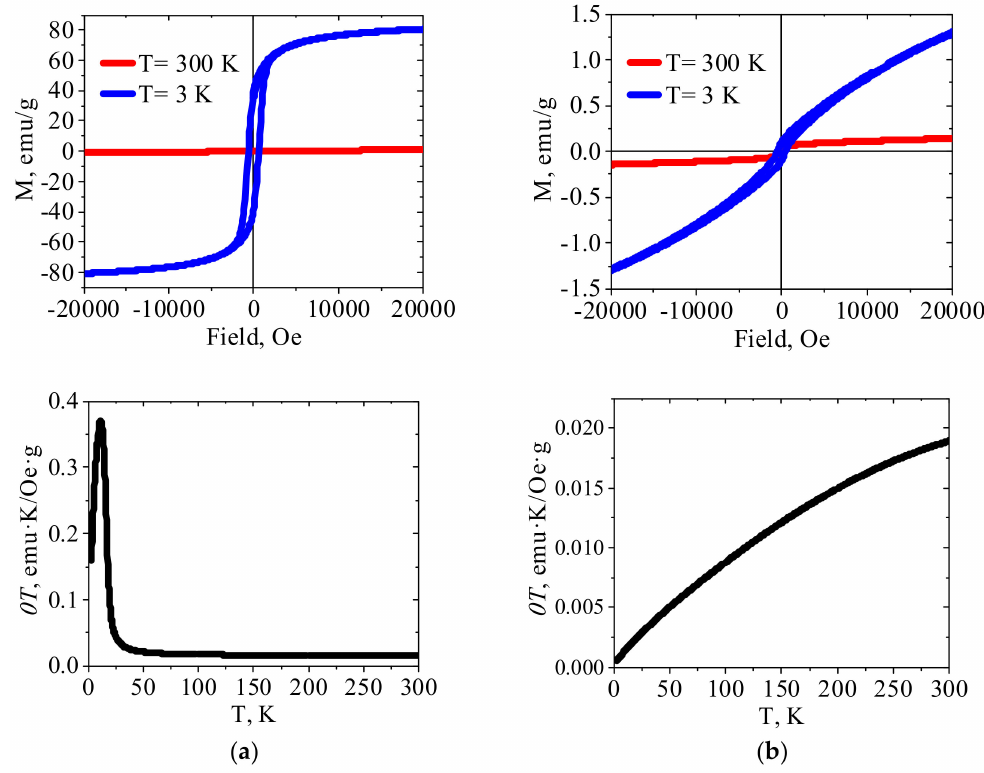
Figure 5. The magnetization curves and χ T temperature dependences for ( a ) crystalline Fe(III)HCF(III) and ( b ) PEI–Fe(III)HCF(III)